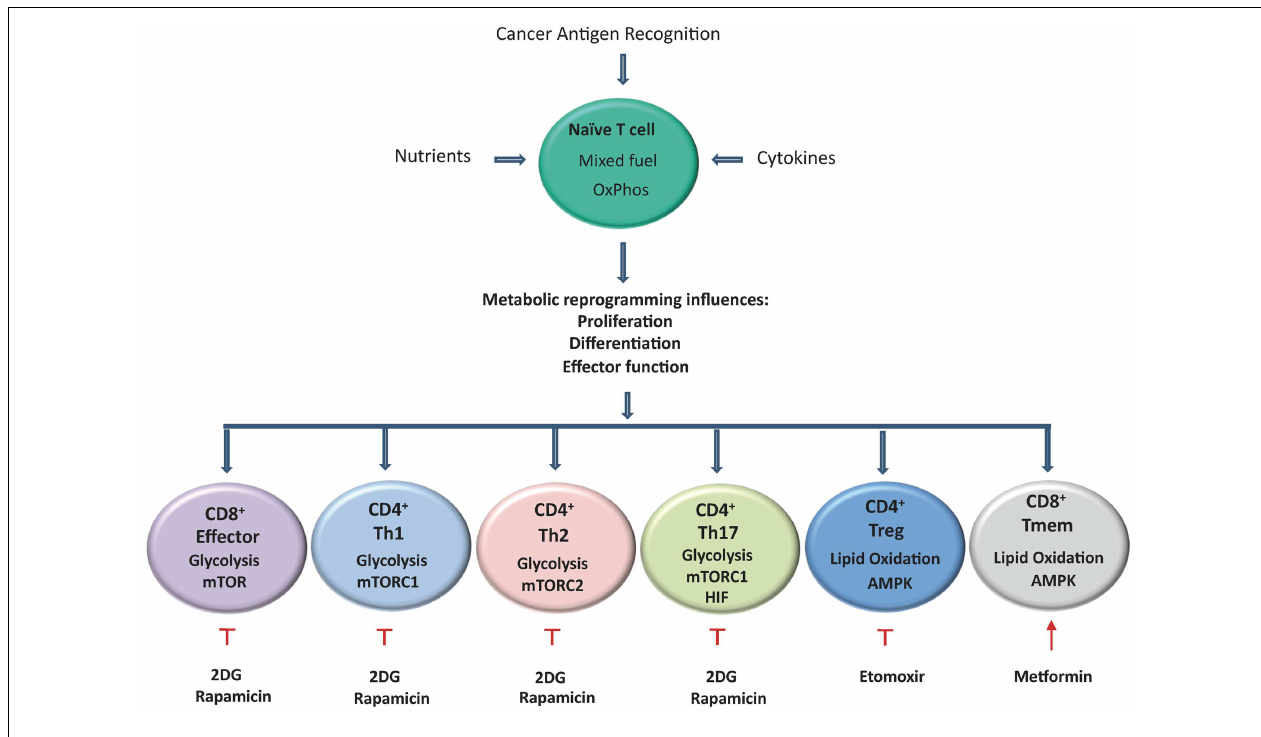
prevalence can be enhanced through the inhibition of glycolysis following treatment with the hexokinase-2 inhibitor 2DG. In addition, inhibition of mTOR by rapamycin and activation of AMPK by the mitochondrial complex I inhibitor metformin can also led to increased survival ofT MEM cells. Etomoxir, a specific inhibitor of CPT1A results in the reduction ofT REG prevalence and has also shown promising results in delaying tumor development.